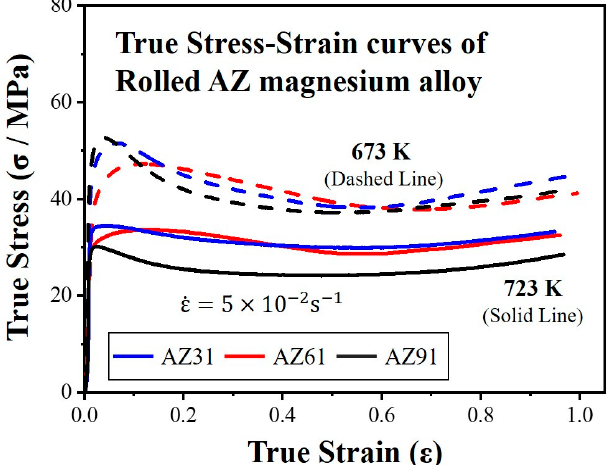
Figure 3. True stress–true strain curves of the AZ-series magnesium alloy with three different solute concentrations deformed at temperatures of 673 K and 723 K under a strain rate of 5.0 × 10 − 2 s − 1